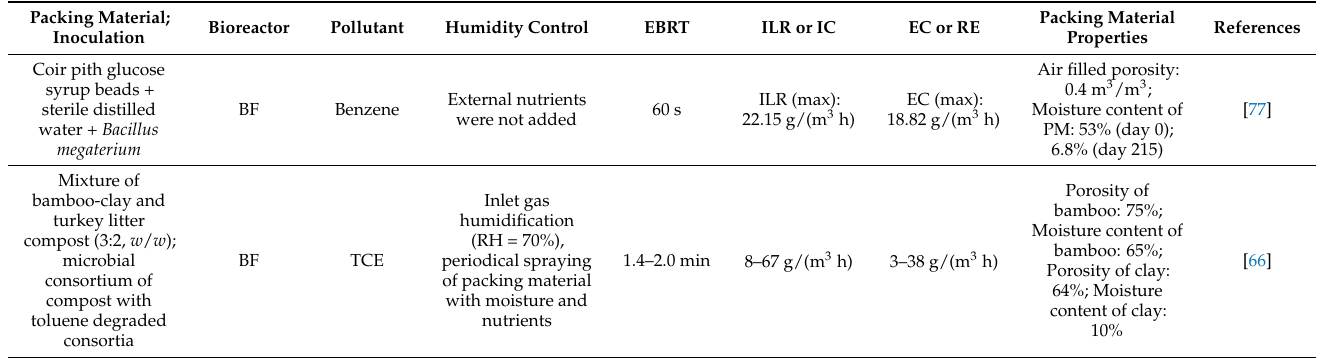
Table 1. Examples of packing materials used in recent biofiltration